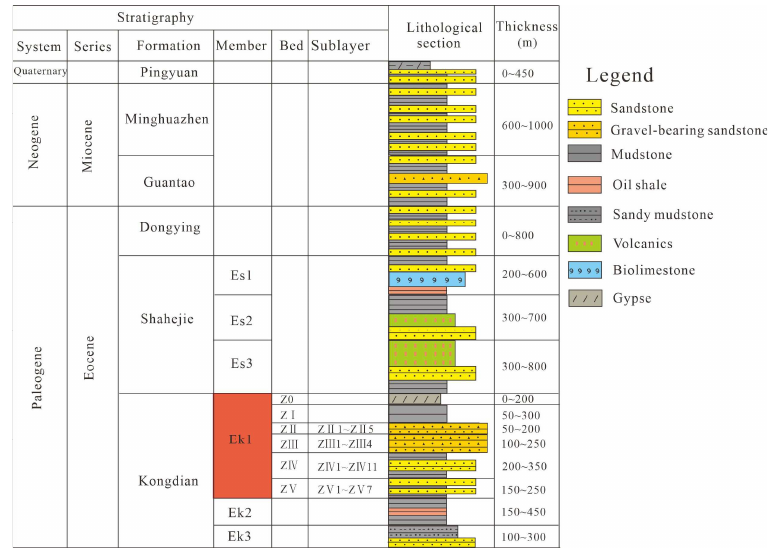
Figure 2. The chrono and lithostratigraphical column of the Wang Guantun Area.